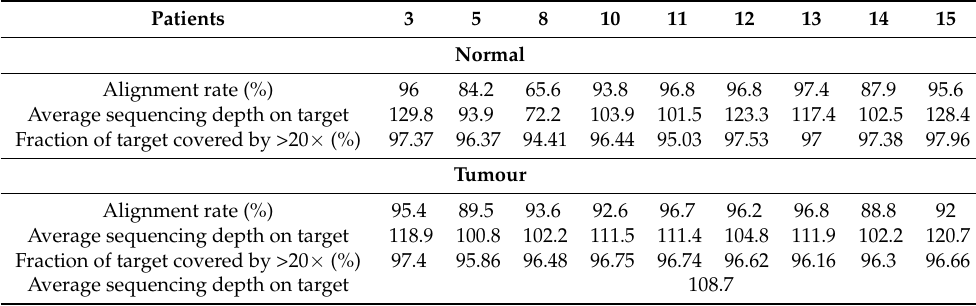
Table 1. Sequencing characteristics for all the samples.